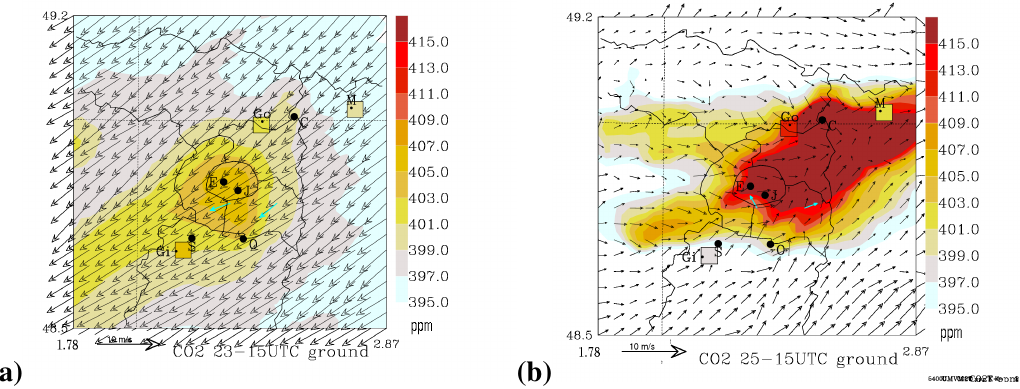
Fig. 14. Horizontal cross sections of CO 2 mixing ratio (in ppm) and predicted wind arrows (in ms − 1 ) near the ground for (a) March 23 at 15:00UTC, (b) 25 March at 15:00UTC